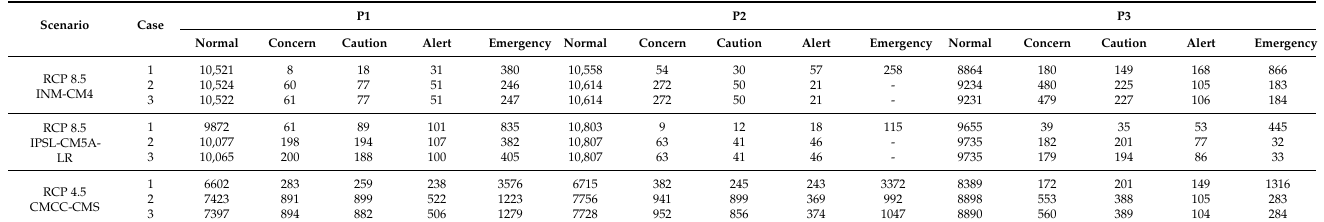
Table 10. Total number of days at each stage for Case 1, 2, and 3 in the Gunwi reservoir.